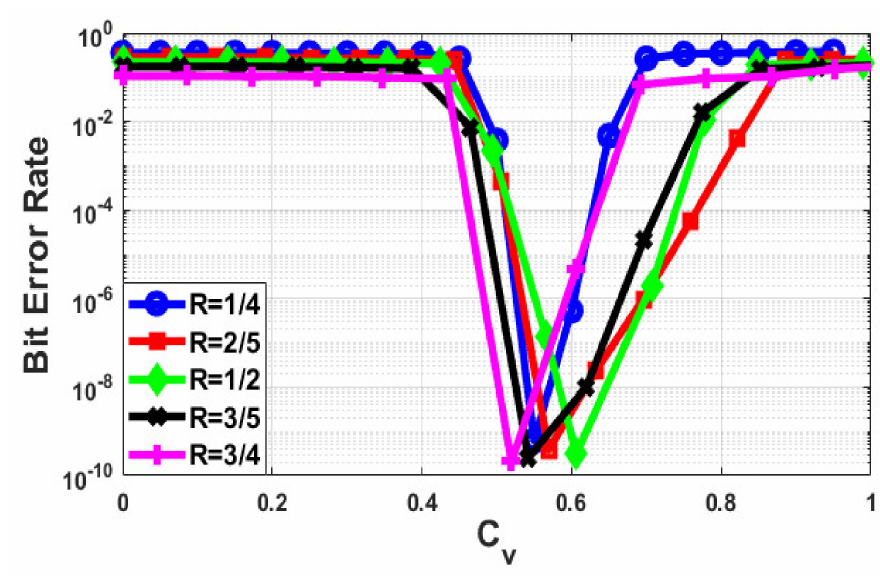
Figure 7. Polar code BER versus coefficient of variation C v for different code rates R .